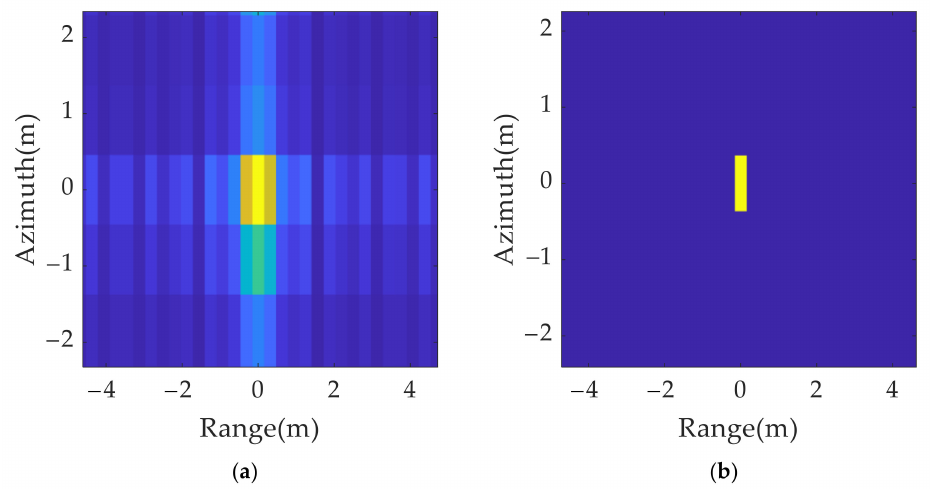
Figure 8. Comparison of single scattering point’s imaging results before and after side lobe elimina- tion: ( a ) without side lobe elimination; ( b ) with side lobe elimination.